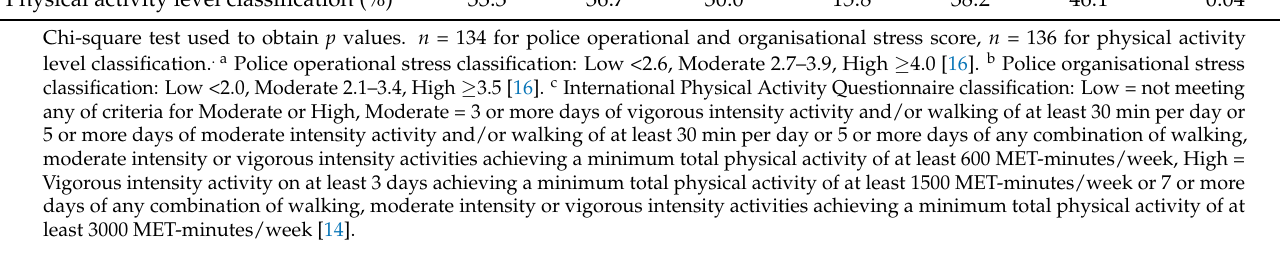
(Table 4). There was a trend for a higher BMI and TC:HDL ratio in operational personnel. There was a trend for higher body fat % and FEV 1 :FVC ratio in non-operational